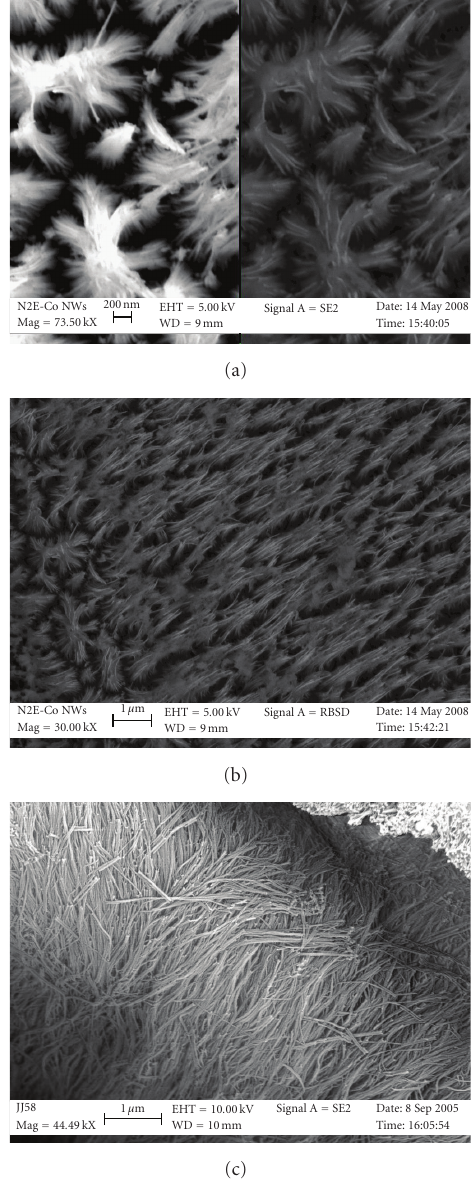
Figure 3: Top view FESEM images for fragments of Co nw arrays fabricated under the optimized AC deposition conditions in the sulfuric acid alumina template pores after the template etching in 0.5M H 3 PO 4 for (a) 30, (b) 70 and (c) 100